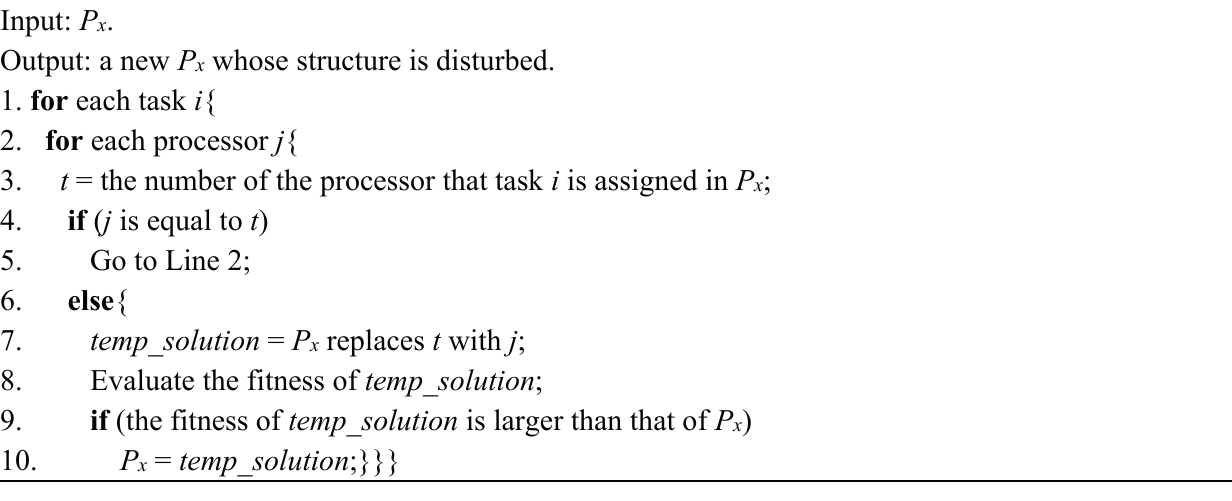
Algorithm 2. P x Disturbance